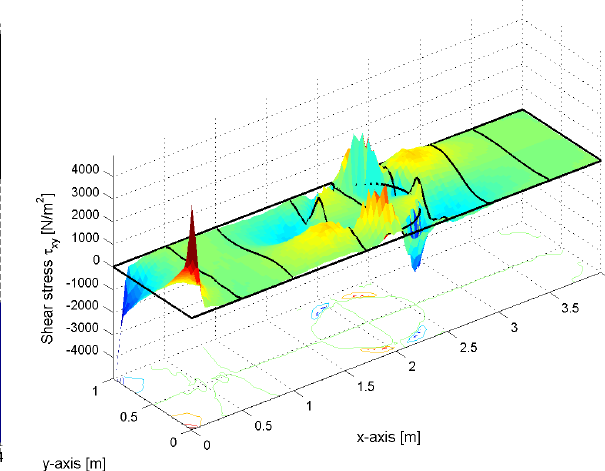
Figure 19: 3D plot of the normal stresses σ x .